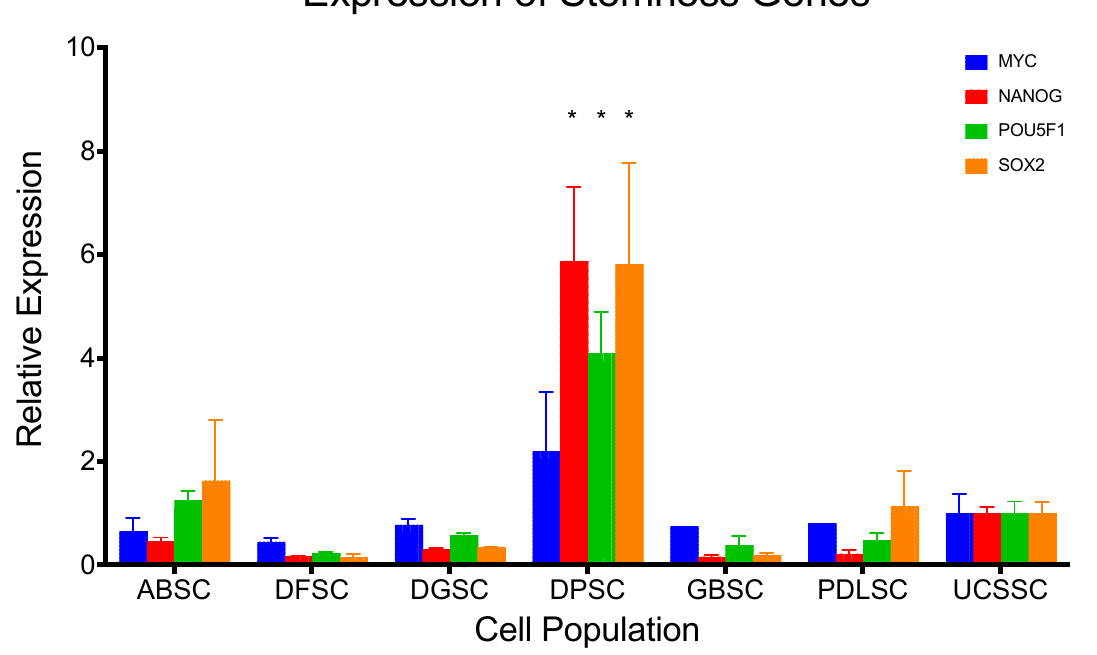
Figure 3. Normalized expression of stemness genes MYC, NANOG, POU5F1, and SOX2 in comparison to mesenchymal stromal cells from the umbilical cord (UCSSC) [9]. Data are shown as mean (SD). *=significant difference compared to UCSSC.